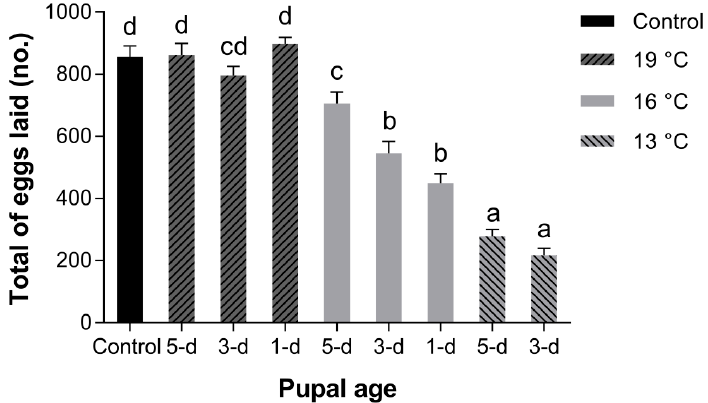
Figure 1. Fecundity of B. dorsalis (GSS) after pupae (1 d old, 3 d old and 5 d old) stored at temperature of 13, 16 and 19 °C. The mean value followed by the same letter does not differ significantly ( p >0.05) according to Tukey’s HSD test (one-way ANOVA).